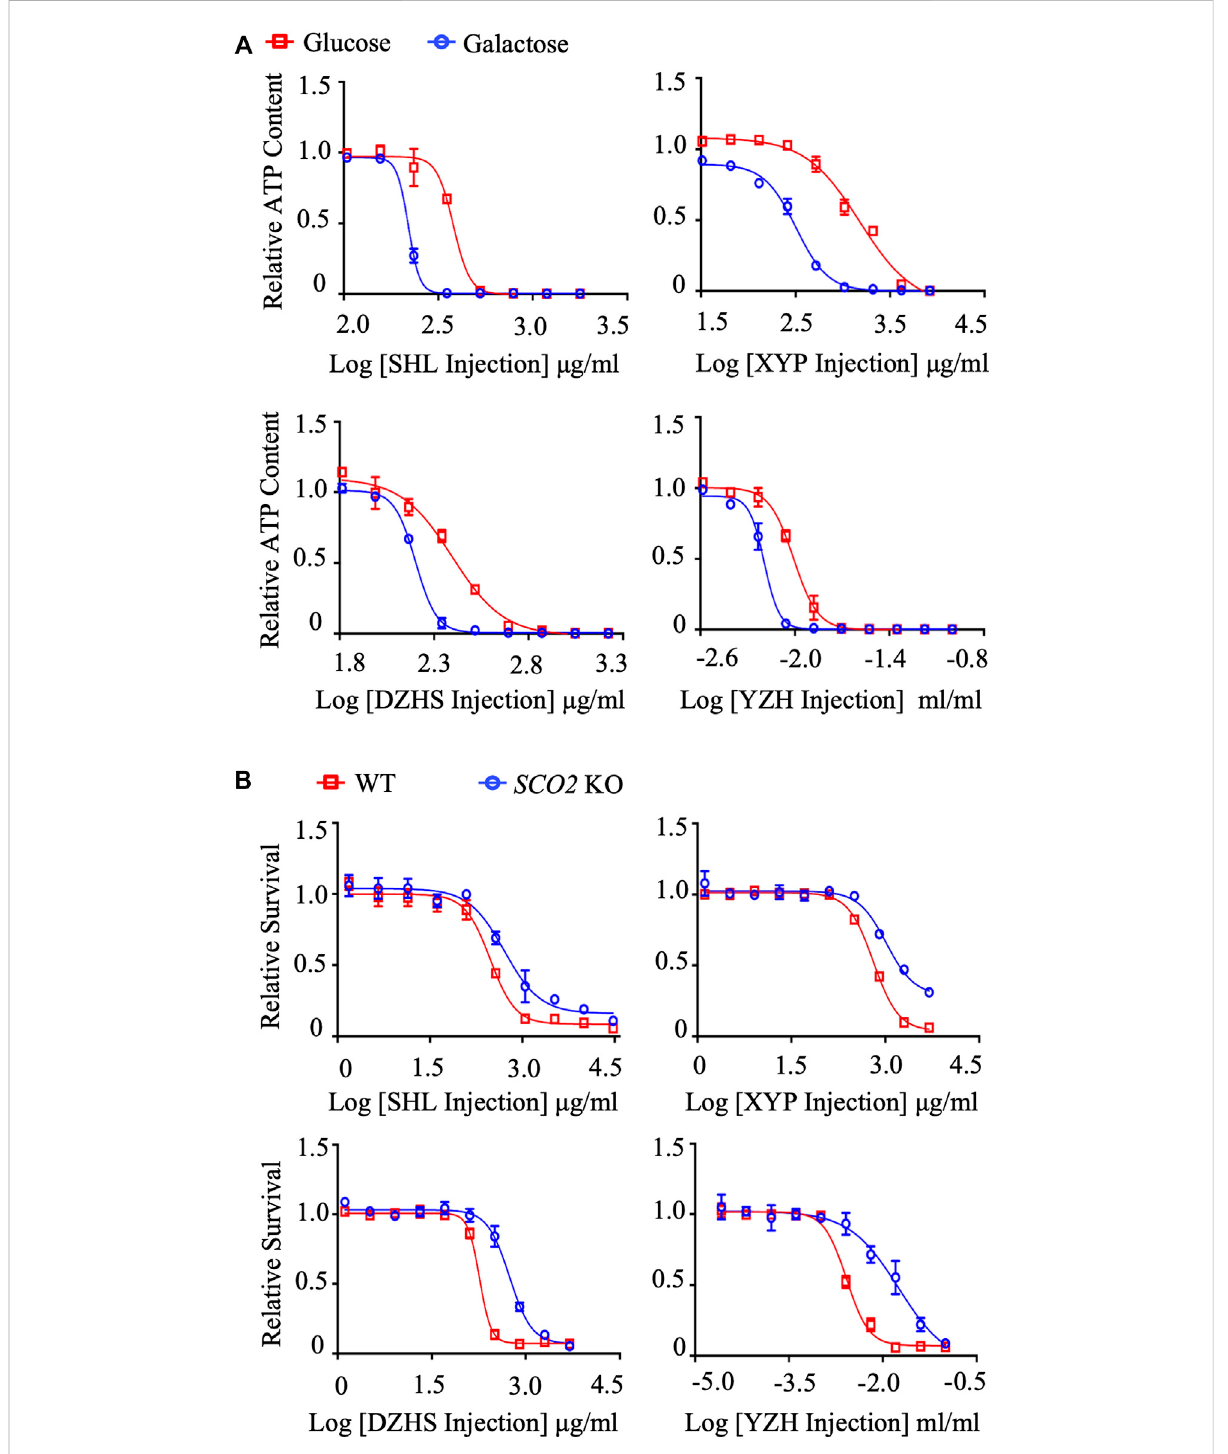
FIGURE 2 Systematic evaluation of mitochondrial toxicity of TCM injections. (A) Concentration responses for high-glucose-grown (25 mM) and galactose-grown(10 mM)(blue)HepG2cellstreatedwithXYP,DZHS,SHLandYZHinjections.After48 hoftreatment,theATPcontentwasassessed. (B) HCT-116 (WT; SCO2 KO) cells were treated with indicated concentrations of XYP, DZHS, SHL, and YZH injections for 72 h. Cell viability was assessed by the SRB assay. Average values are from three independent experiments performed in duplicate ( n = 3). Data are shown as mean ±